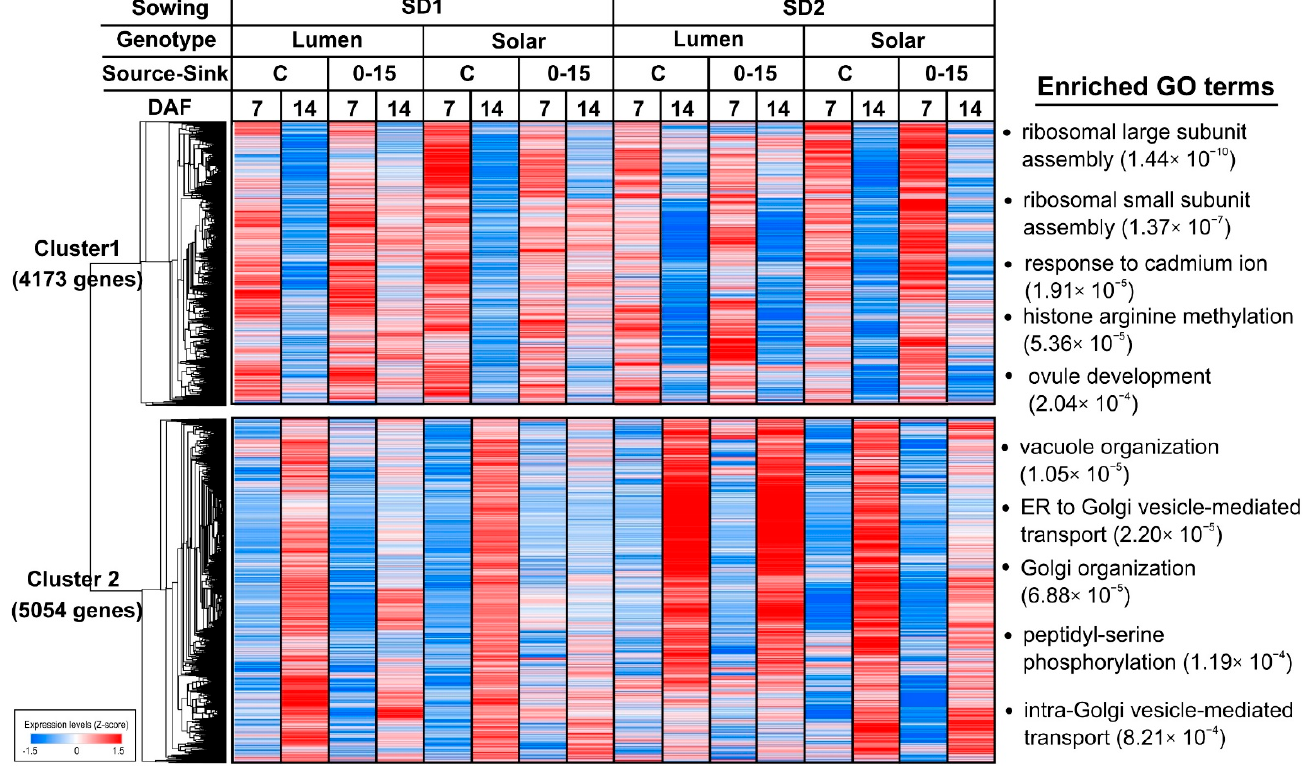
Figure 2. Genes exclusively regulated by developmental time are associated with seed filling. A heatmap showing the two major expression patterns of genes exclusively regulated by developmental time. Hierarchical clustering was performed based on Pearson correlation distances and average linkage using Morpheus software [29]. Each column of the heatmap represents the average expression of three biological replicates. The gene expression values for each gene were normalized by Z-score transformation. The top 5 enriched GO terms of the biological process domain are represented on the right side of each cluster. GO term enrichment analysis was performed by a hypergeometric test using BiNGO software [28]. FDR- corrected p -values are indicated for each GO term in brackets. SD = sowing date, DAF = days after flowering, C = control, 0–15 = source to sink treatments performed from the beginning of flowering to 15 DAF.